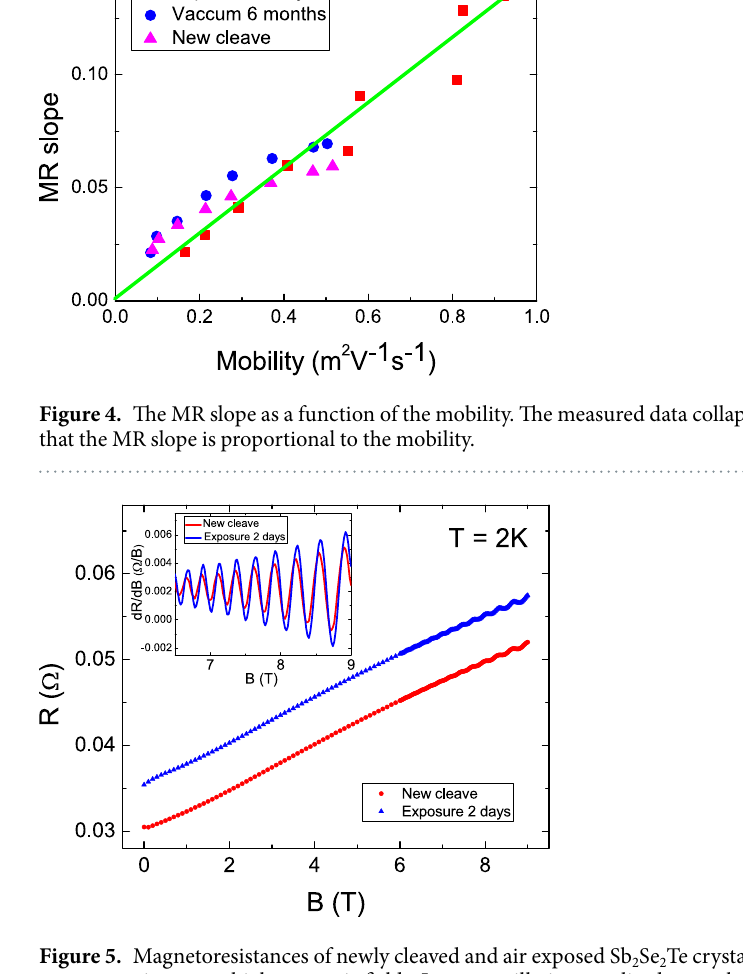
Figure 5. Magnetoresistances of newly cleaved and air exposed Sb 2 Se 2 Te crystal. Inset differential of the magnetoresistance at high magnetic fields. Larger oscillation amplitude was observed after N 2